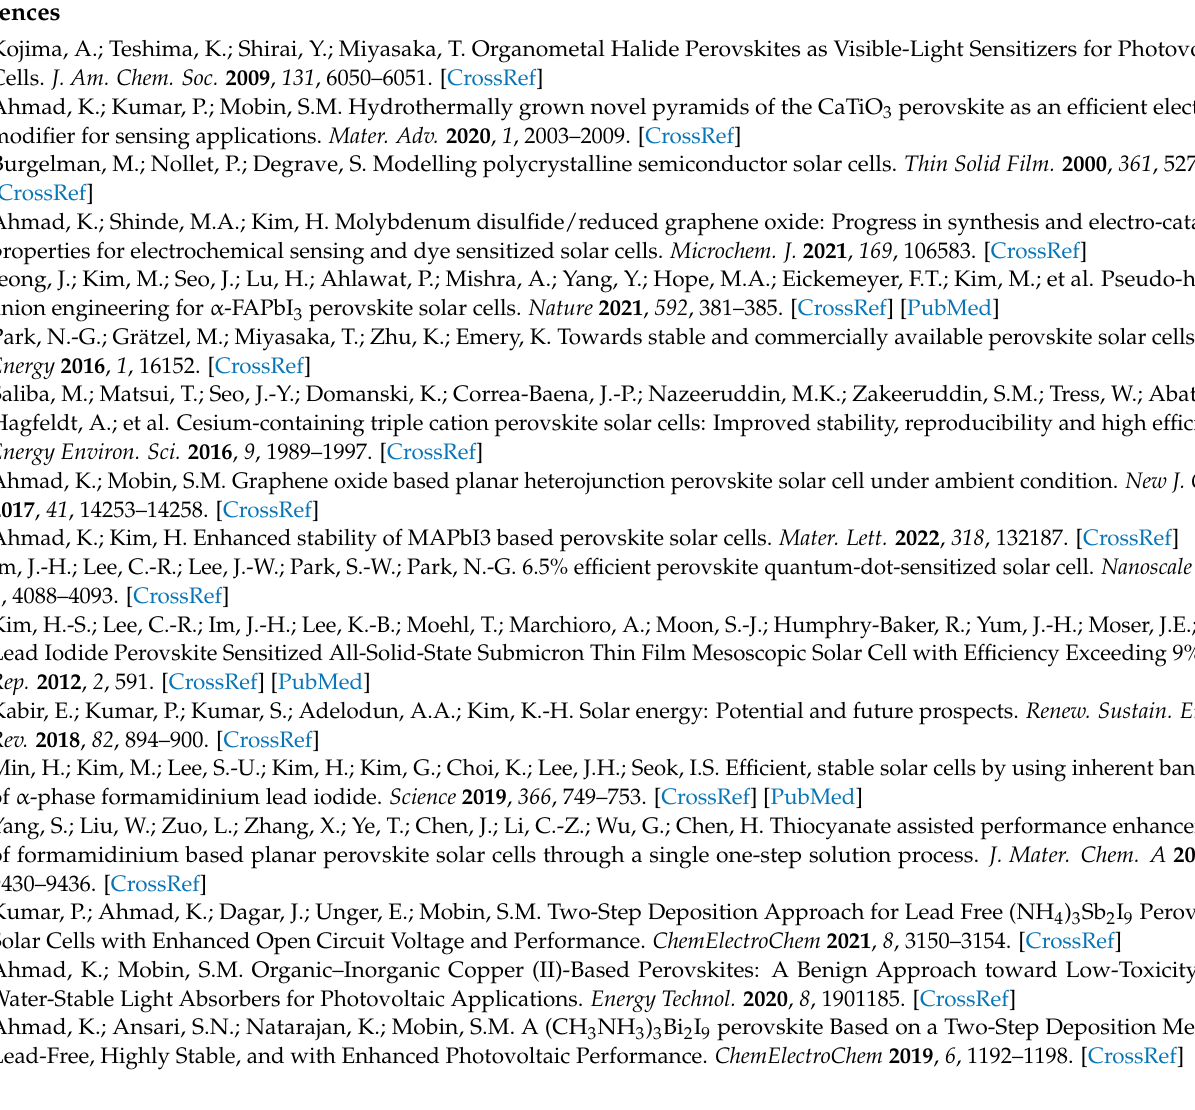
terials for device simulation. Table S2. Effect of thickness of TiO 2 on photovoltaic parameters. Table S3. Effect of spiro-OMeTAD thickness. Table S4. Effect of absorber layer. Figure S1. J-V responses of the simulated and fabricated PSCs